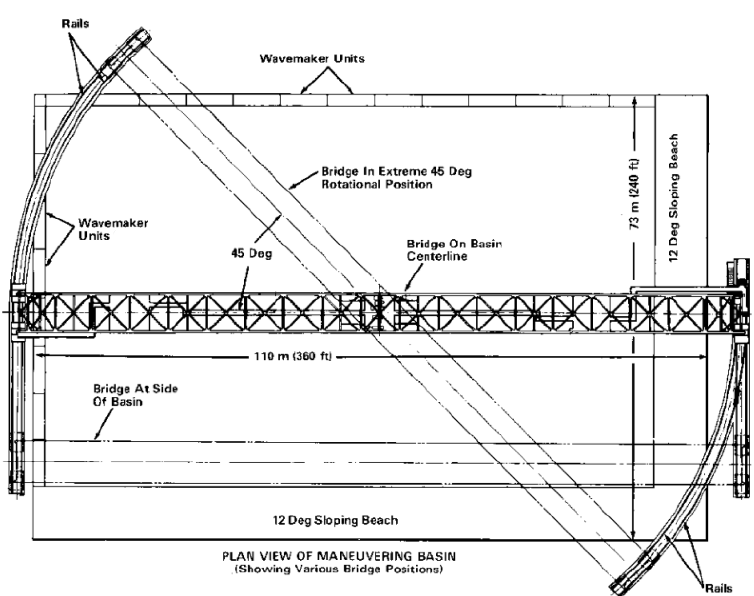
Figure 5. Top view diagram of MASK basin with gantry bridge.